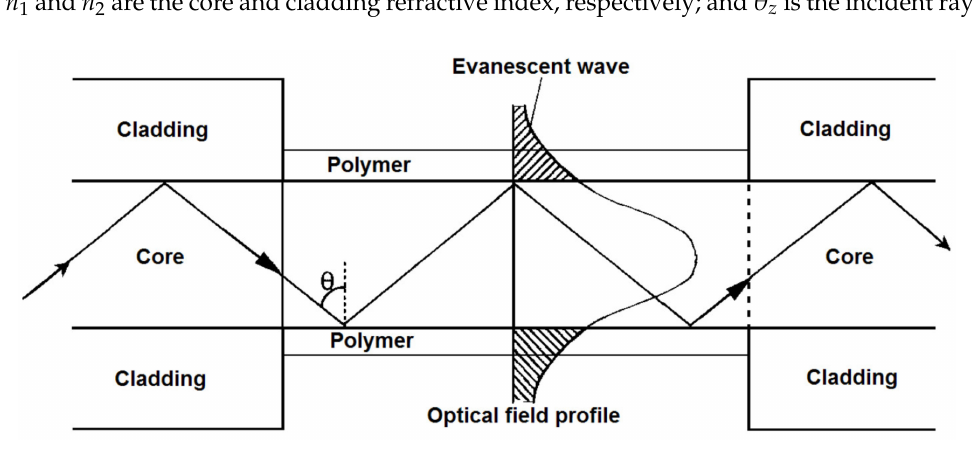
Figure 10. Sensor principle and evanescent wave field (fundamental mode) in an optical fiber. Reproduced with permission [62]. Copyright 2014, SPIE.